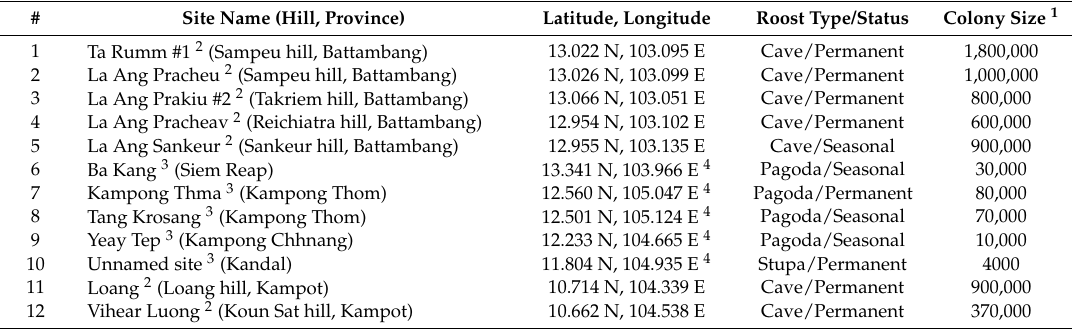
Table 1. Summary characteristics of major Chaerephon plicatus colonies in